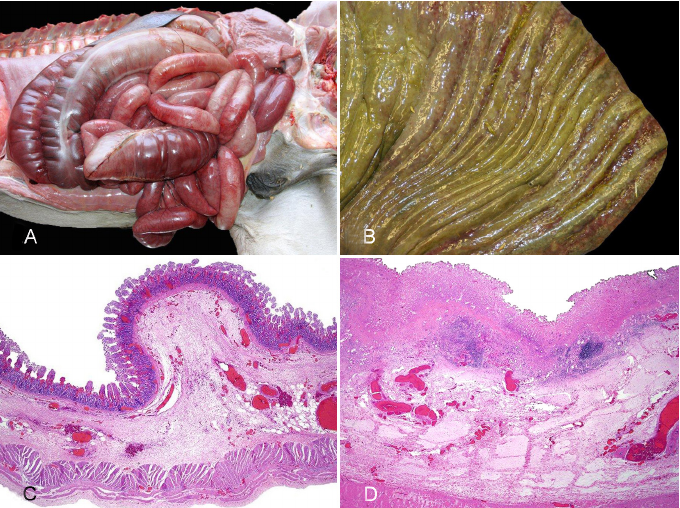
Figure 2. Horse with enterocolitis produced by Clostridioides difficile . ( A ) There is diffuse red discoloration in the serosa of most of the small intestine and colon. ( B ) The mucosa of the colon is congested and hemorrhagic, has thickened folds and it is covered by a fibrinous pseudomembrane. ( C ) The small intestine shows villus blunting, loss of superficial epithelium, congestion and hemorrhage of the mucosa and severe submucosal congestion and edema. ( D ) There is diffuse necrosis of the mucosa, which is covered by a pseudomembrane, and congestion and edema of the submucosa. Reprinted with permission from ref. [29]. Copyright 2013 Vet Pathol.